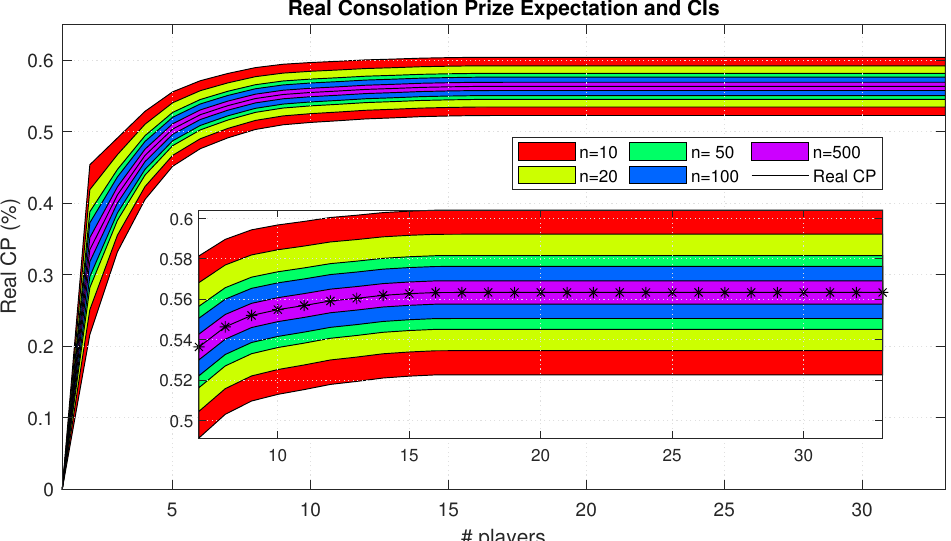
Figure 8. Real consolation prize expectation and CIs (second gaming